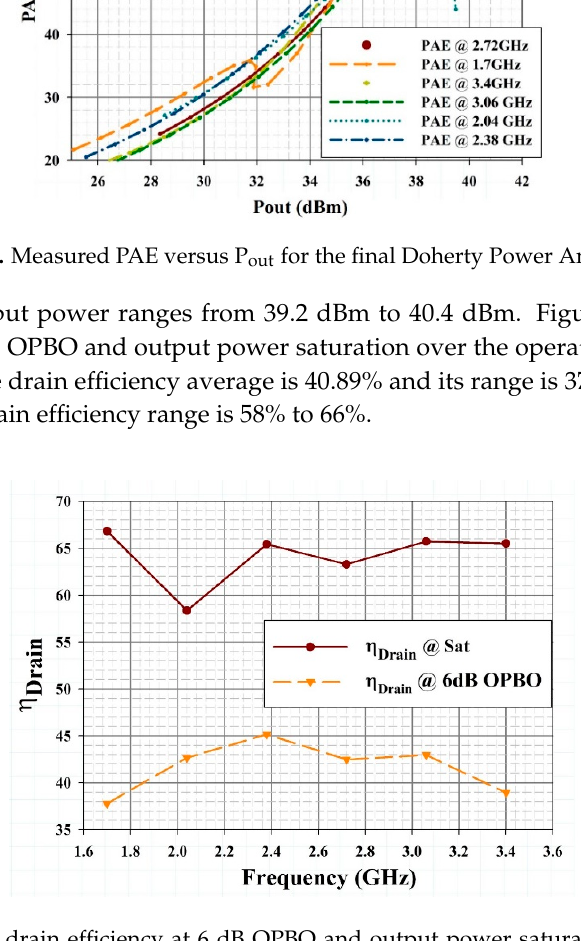
Figure 19. Measured Gain (dB) versus P in (dBm) for the Doherty Amplifier in Figure 16. Figure 20. Input reflection coefficient for the fabricated Doherty Amplifier.